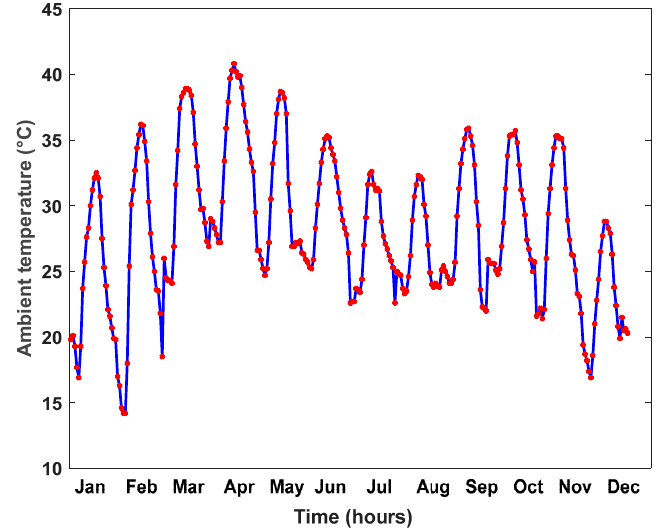
Figure 4. Monthly hourly ambient temperature of Salak.